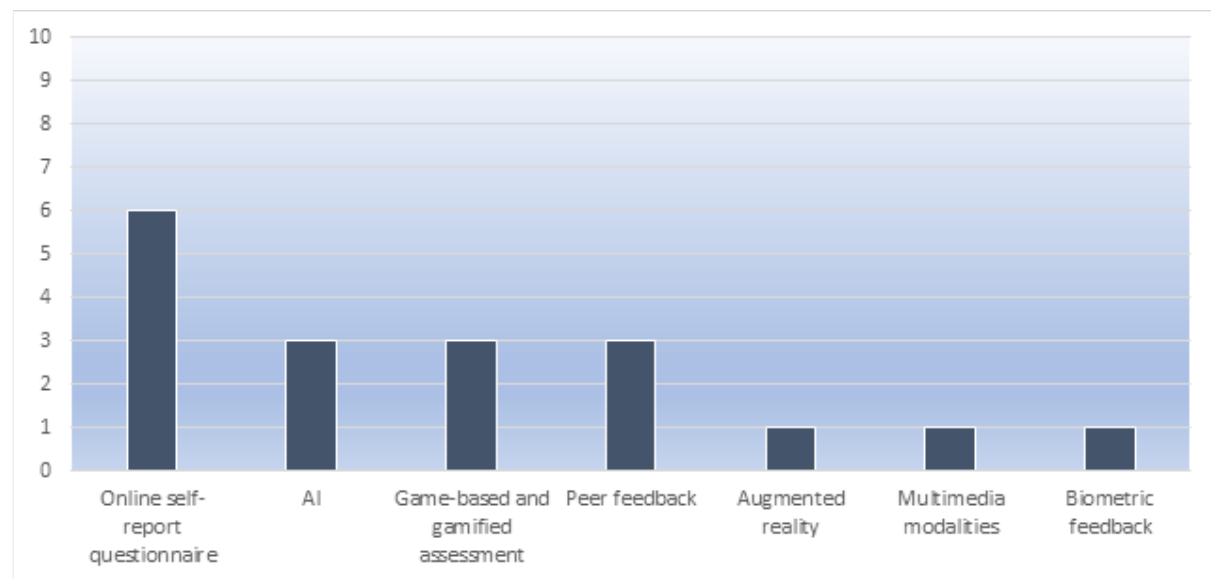
Digital Assessment of University Students’ Well